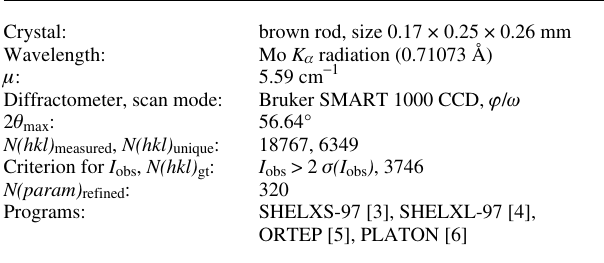
Table 1. Data collection and handling.